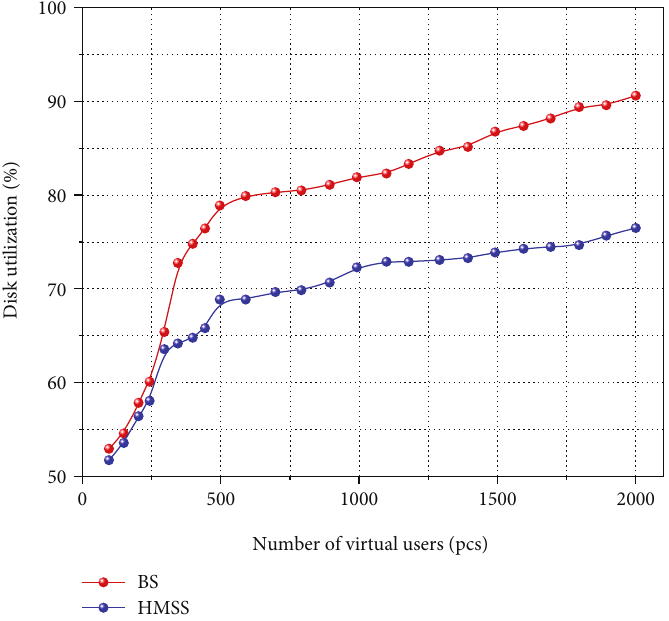
Figure 6: Disk utilization comparison between HMSS and benchmark certi fi cation